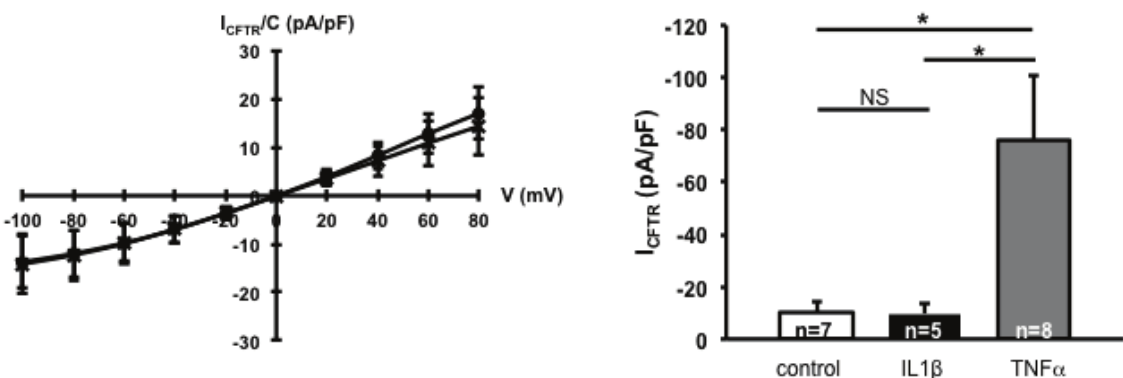
Figure 4. Effect of IL-1 β on F508del-CFTR expressing HeLa cells. * indicates significant results. I HeLa cells by patch clamp. Mean CFTR related current-voltage relationships recorded in the presence of 400 µM CPT-cAMP/100 µM IBMX ( O ) and the presence of 10ng/ml IL1 β + CPT-cAMP/IBMX ( X ). The current was normalized to capacity (pA/pF), left panel. The normalized CFTR currents are depicted as mean + SEM, in absence (control, white column) or presence of 10ng/ml IL1 β for 10min (IL1 β , black column) or presence of 50ng/ml TNF α for 10min (TNF α , grey column). IL1 β did not significantly increase I significantly increased I